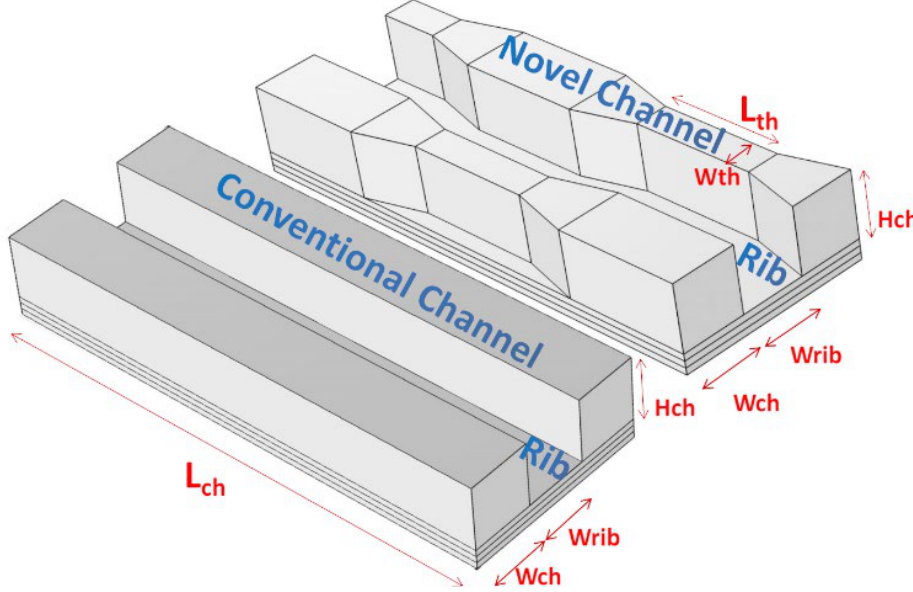
Figure 2. A geometry comparison between the conventional channel and the novel channel. For the geometric and operating parameter comparison between the conventional channel and the novel channel, see Table 1. Table 1. Geometric and operating parameters for the SOEC with the conventional and the novel